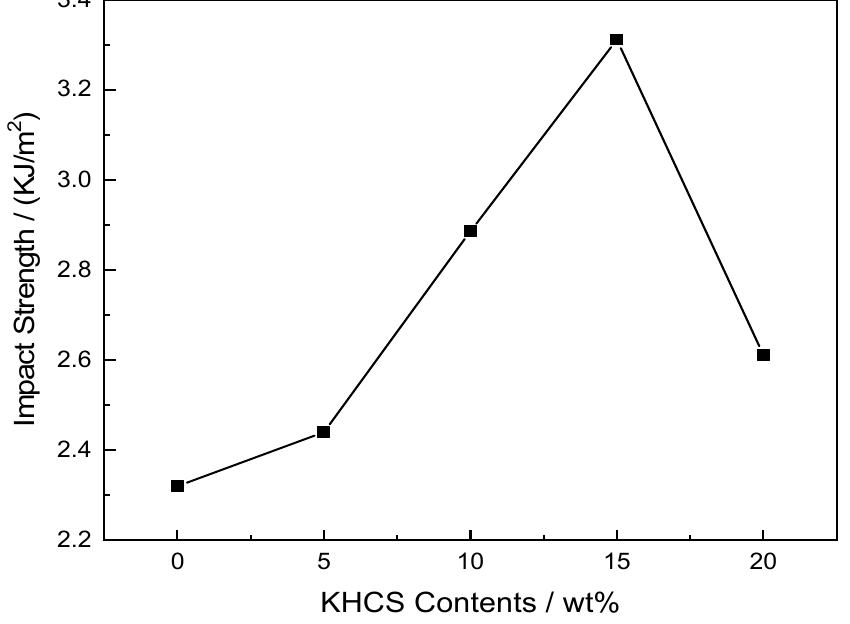
Figure 7. Impact strength curve of the composites.